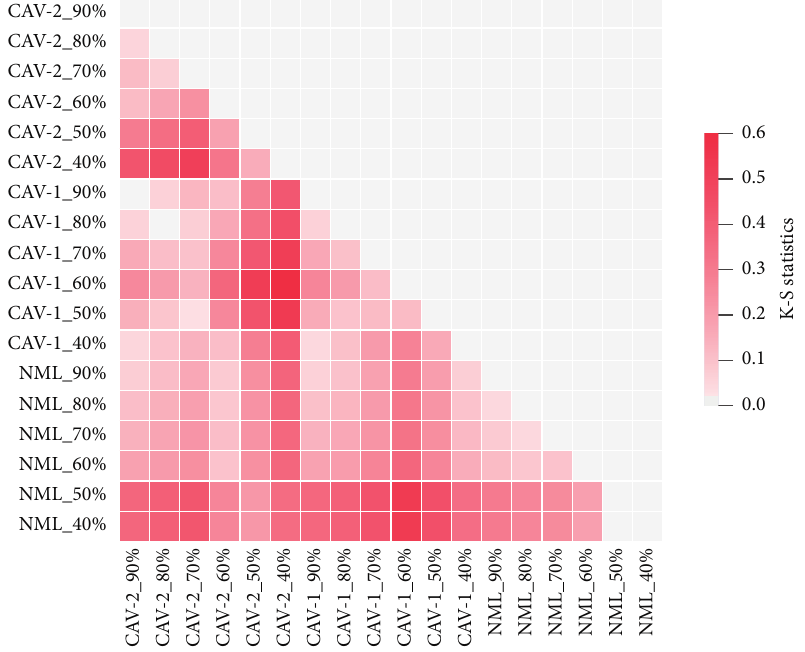
Figure 4: K-S statistics for CDF